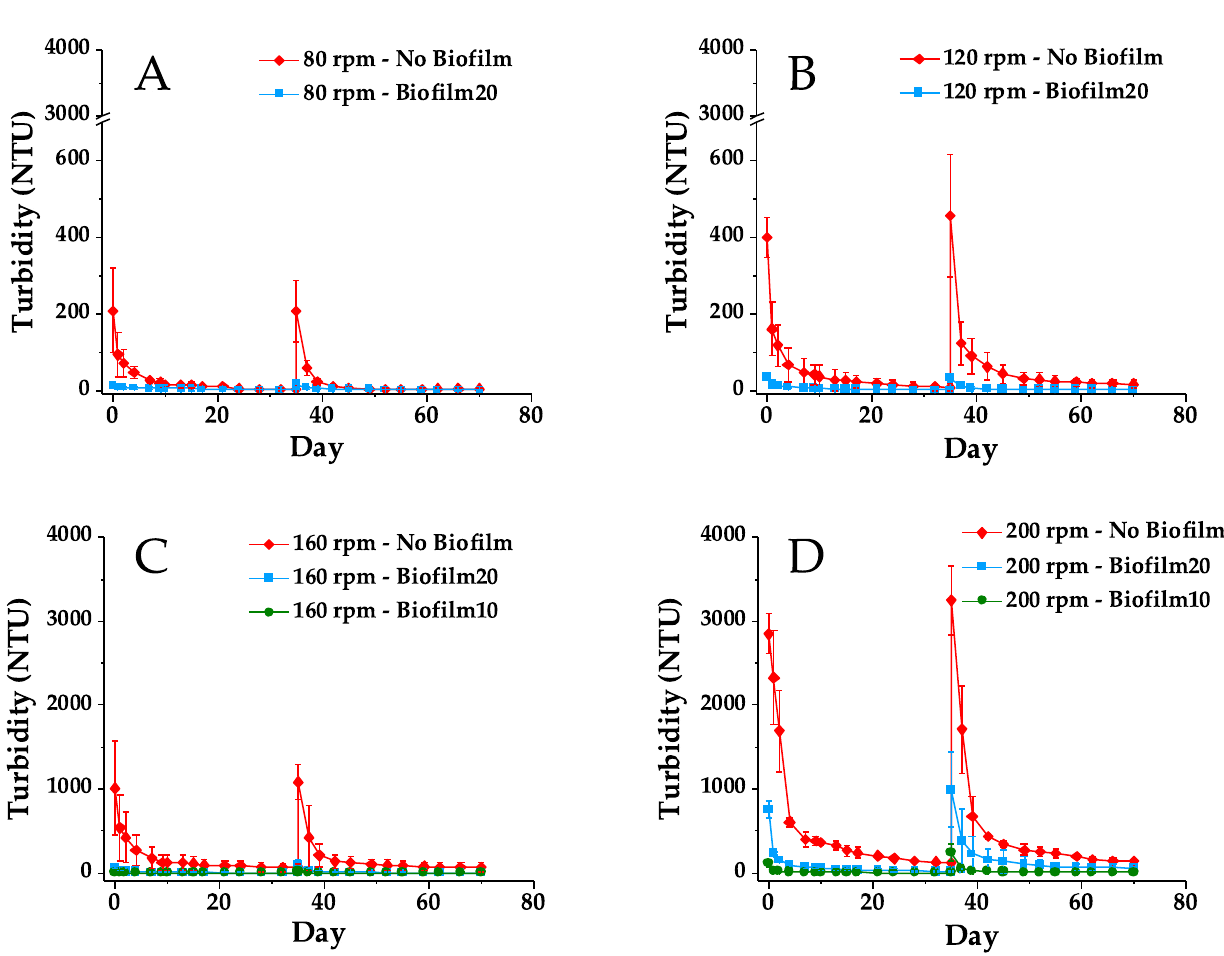
Figure 5. Turbidity in No Biofilm, Biofilm10, and Biofilm20 jars during first and second mixing tests. ( A – D ) correspond to mixing speeds of 80, 120, 160, and 200 rpm, respectively. Results are presented as average ± one standard deviation of triplicates. The spike in turbidity at Day 35 corresponds to the turbidity immediately after the second 1-h mixing period. Note that A and B have y-axis breaks between 600 and 3000 NTU. Biofilm10 corresponds to 10-week-old biofilms; Biofilm20 corresponds to 20-week-old biofilms.